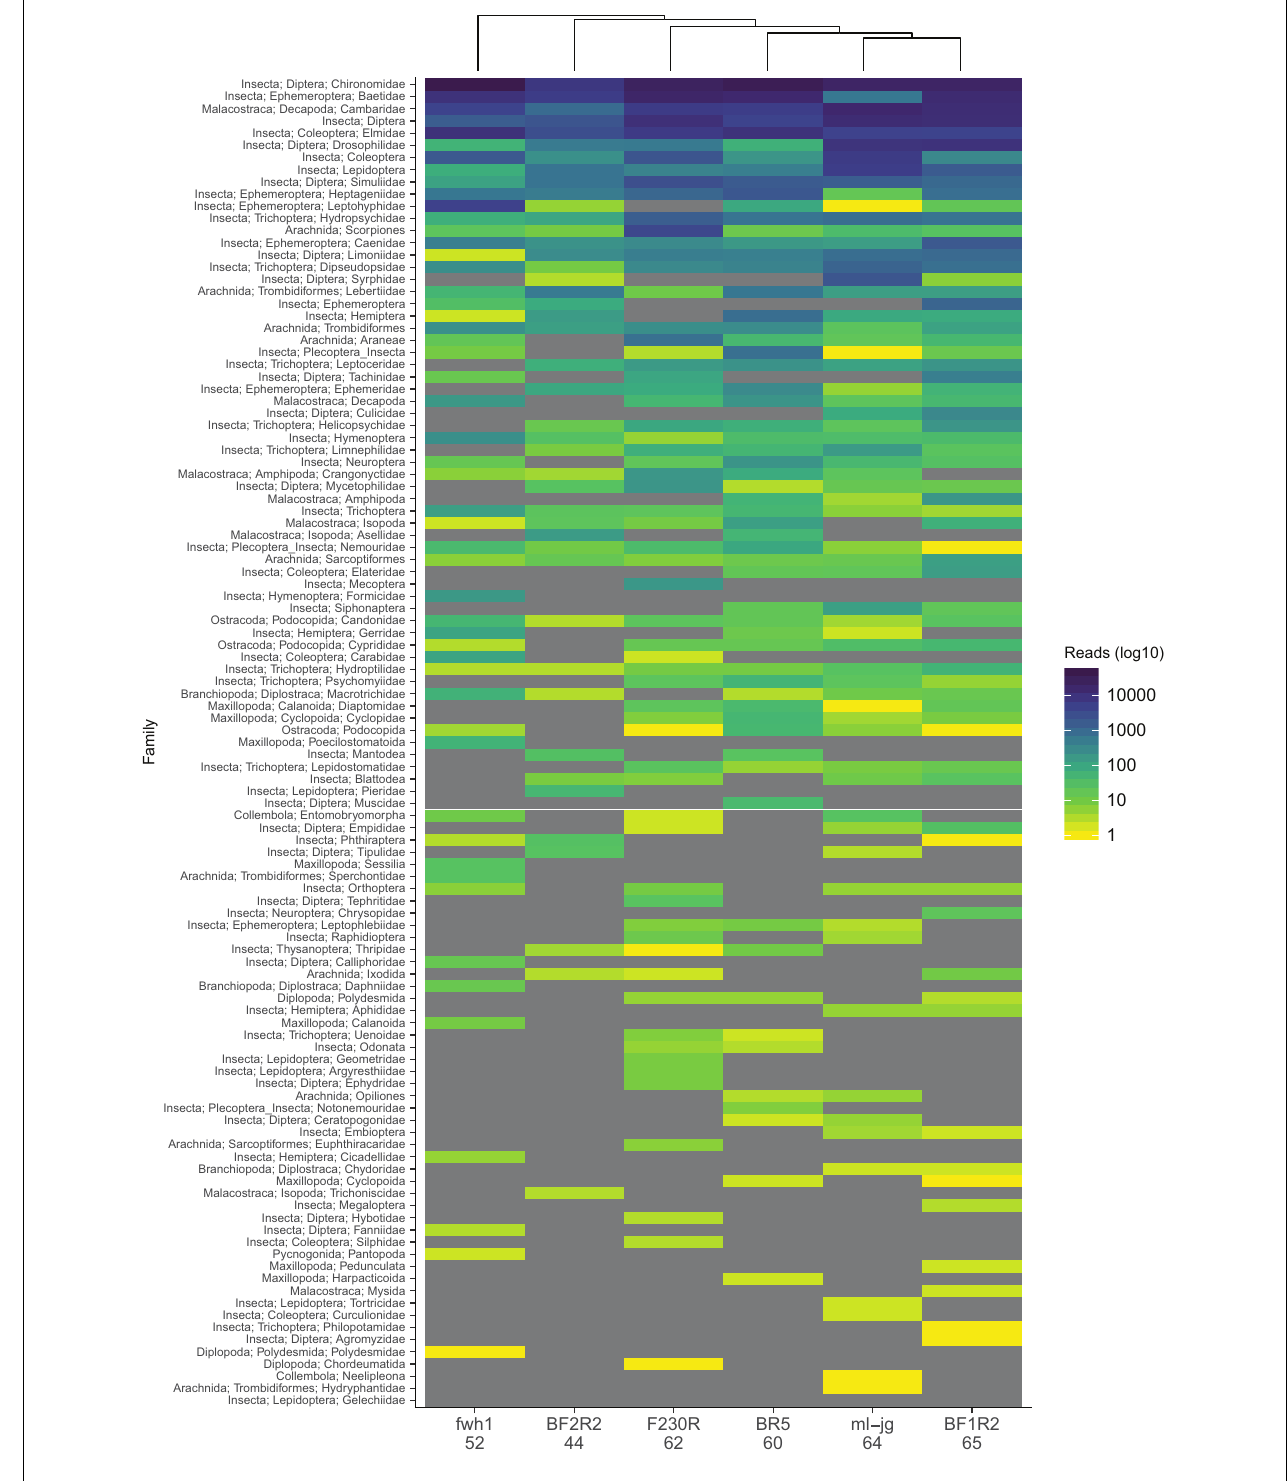
FIGURE 3 | Observed community composition can vary based on choice of COI amplicon. Data is from a study that assessed arthropod diversity using COI metabarcoding of 6 amplicons from freshwater kick net samples (Hajibabaei et al., 2019). Number of unique taxa detected from each primer set is indicated below the COI amplicon name on the x -axis. Results are based on ESVs whose taxonomic assignments have been summarized to the family rank where possible on the y -axis and ordered by decreasing read number (see legend). A UPGMA dendrogram is shown above the heatmap, indicating which amplicons recover communities that are most similar to each other. Fields in “gray” indicate that zero reads were